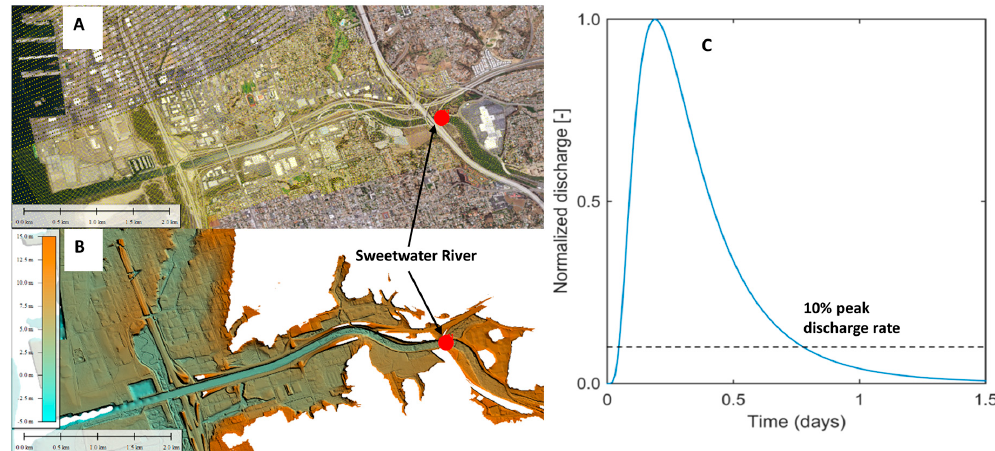
Figure 7. Illustration of discharge inclusion in Tier II hydrodynamic models: ( A ) high resolution model grid in San Diego, CA with discharge location shown as red dot; ( B ) elevation of same location with gauge location shown as red dot; and ( C ) normalized hydrograph used in discharge time-series included in each hydrodynamic simulation. Hydrograph was scaled by a river’s estimated peak discharge, Q 21 .